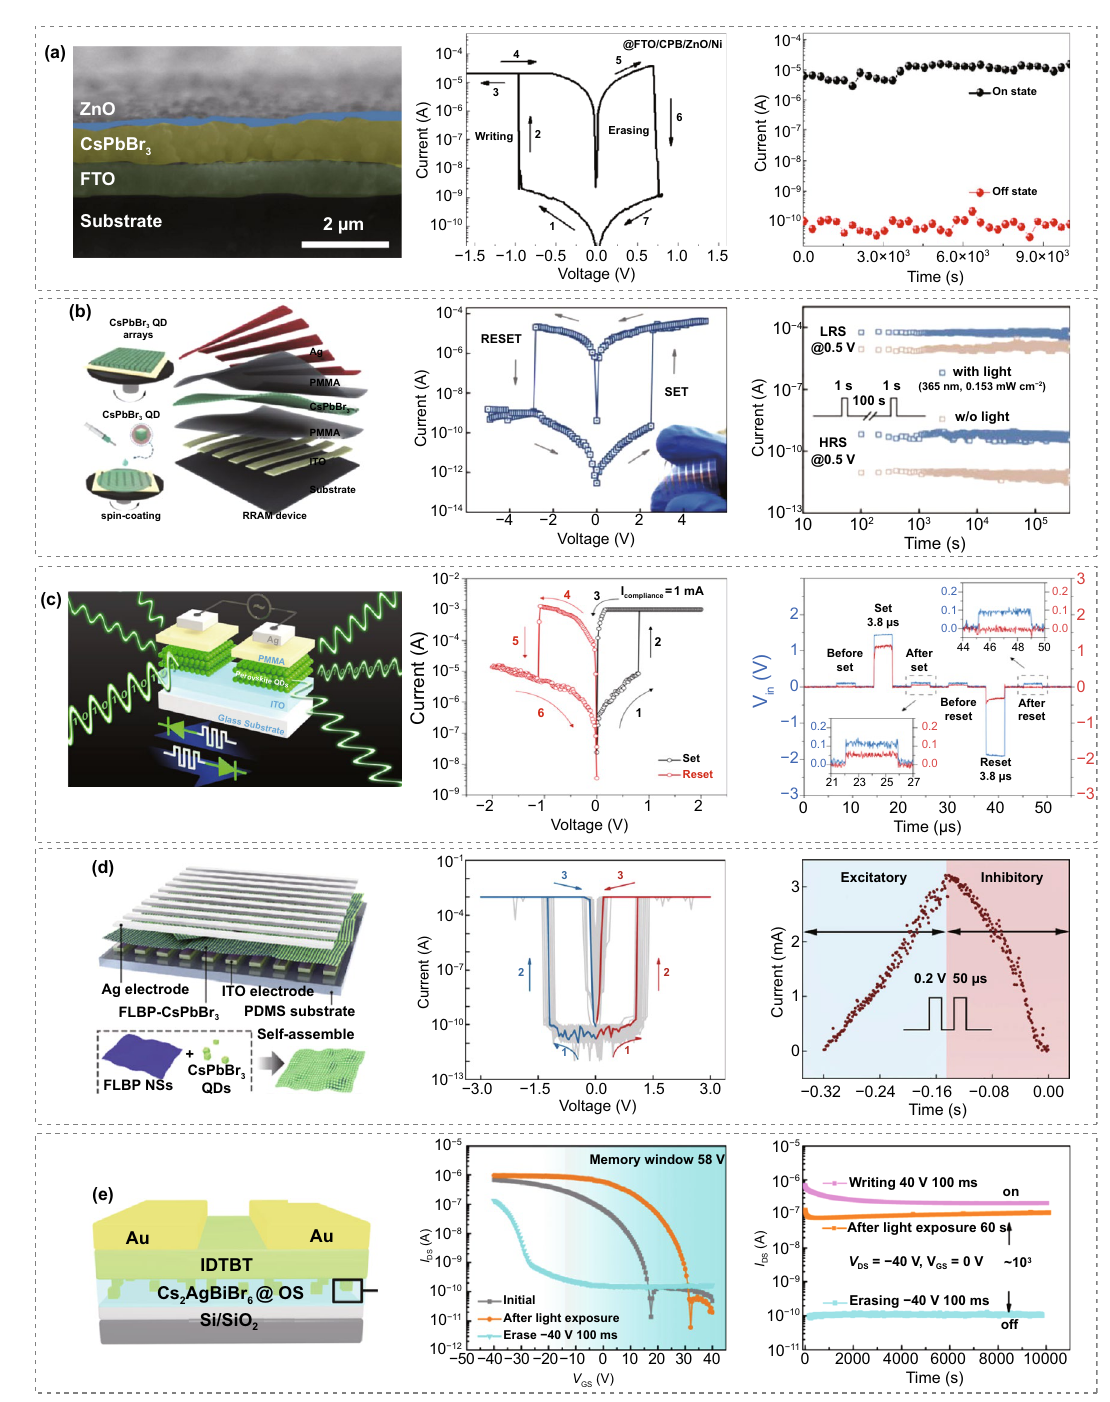
Fig. 6 a Cross-sectional SEM image of the Ni/ZnO/CsPbBr 3 QDs/FTO memristor, typical I–V curves, and retention measurement. Adapted with permission from Ref. [188]. Copyright 2017, Springer. b Schematic diagram of CsPbBr 3 QD-based logic OR device, its photonic